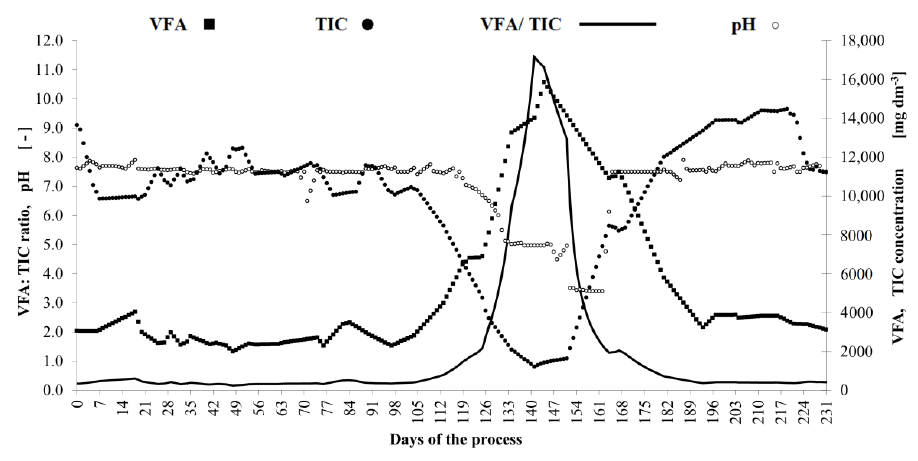
Figure 4. Biogas production and its CH 4 content.